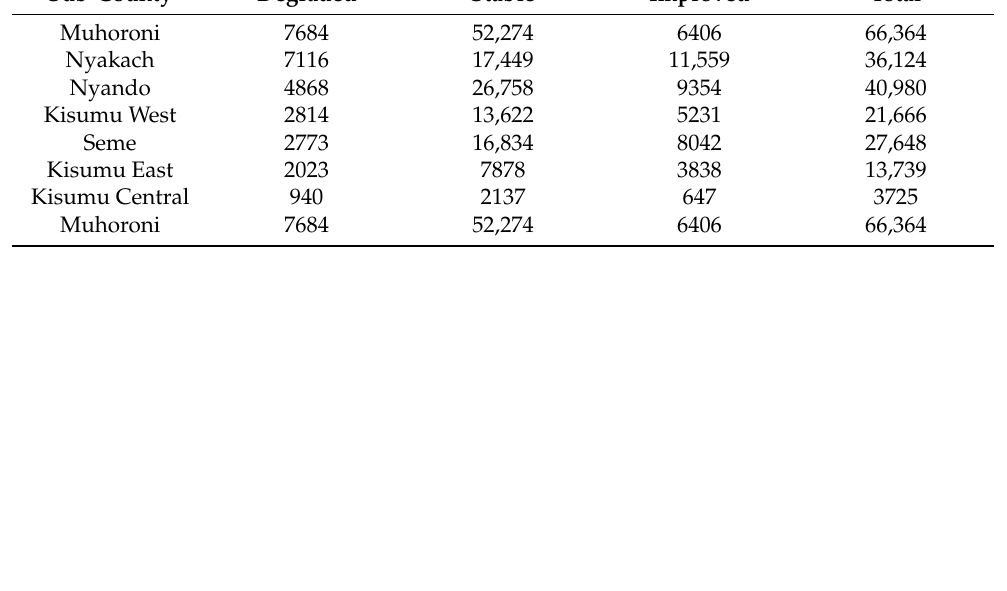
Figure 9. Risk class calculated as a function of change between historical (1981–2010) and future projected (2041–2070) period through length of growing period (LGP) and the population in Fokontany level, Analamanga region, Madagascar at RCP 2.6, 4.5 and 8.5 scenarios. Table 7. The extent of land status (ha) between 2016–2020 in the Kisumu subcounty.